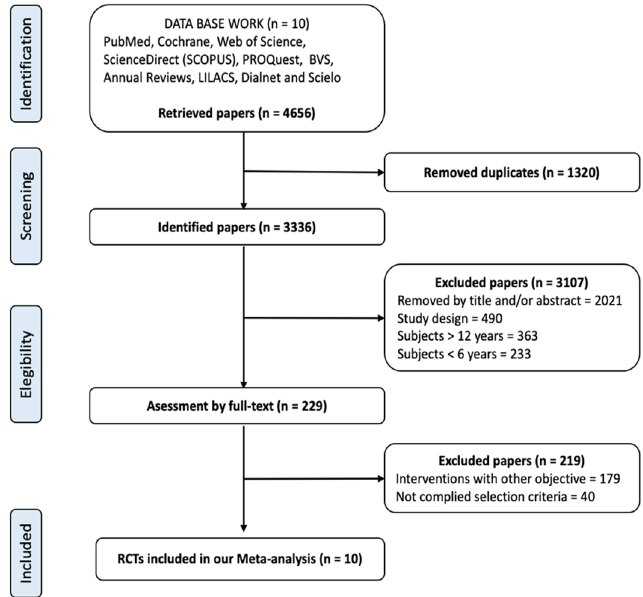
Figure 1. Flow diagram for the scientific paper selection from databases. RCTs, randomized controlled trials.